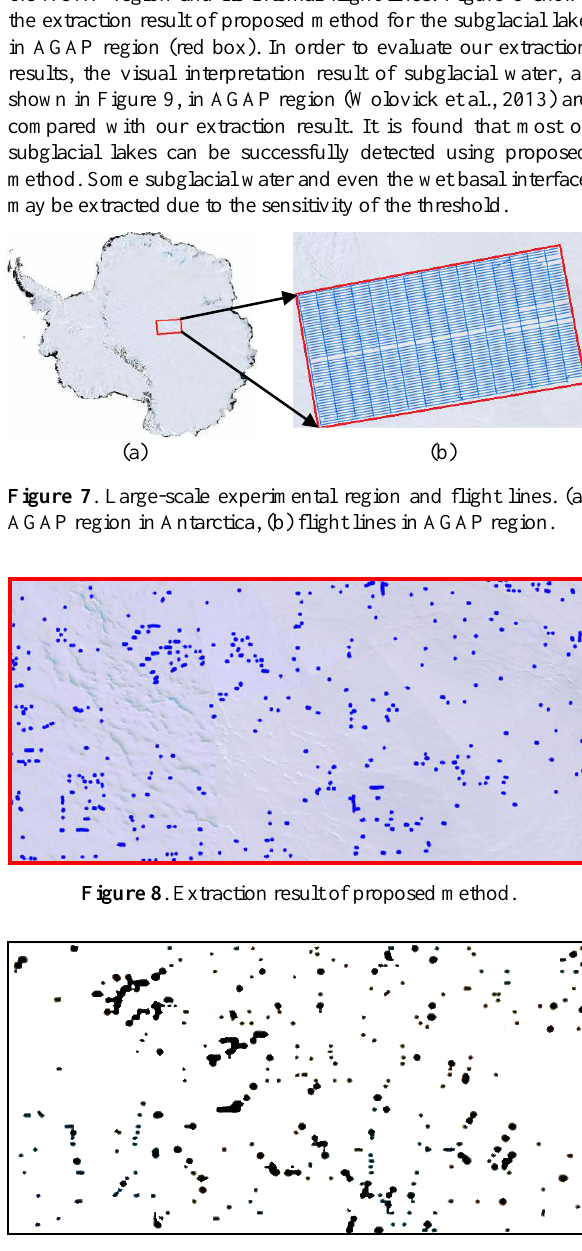
Figure 9 . Visual interpretation result in AGAP (Wolovick et al.,